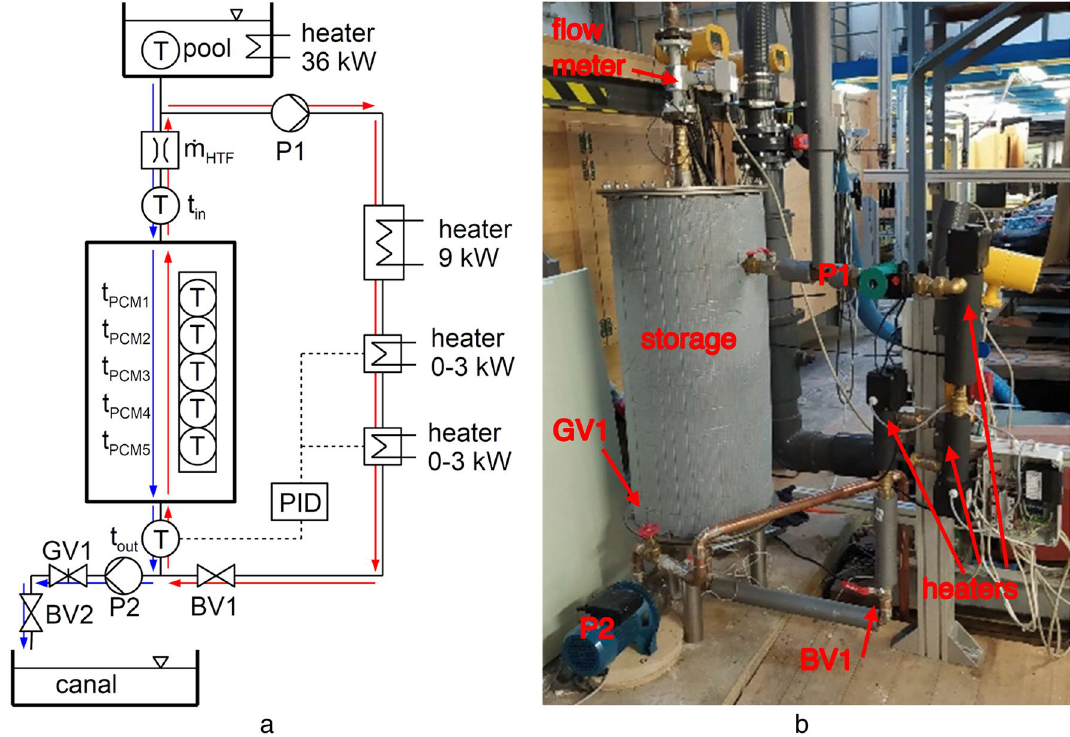
Figure 4. The diagram of the experimental circuit with the latent heat storage. ( a ) The HTF flow direction marked for charging (red arrows) and discharging (blue arrows) of the storage. ( b ) The real experimental